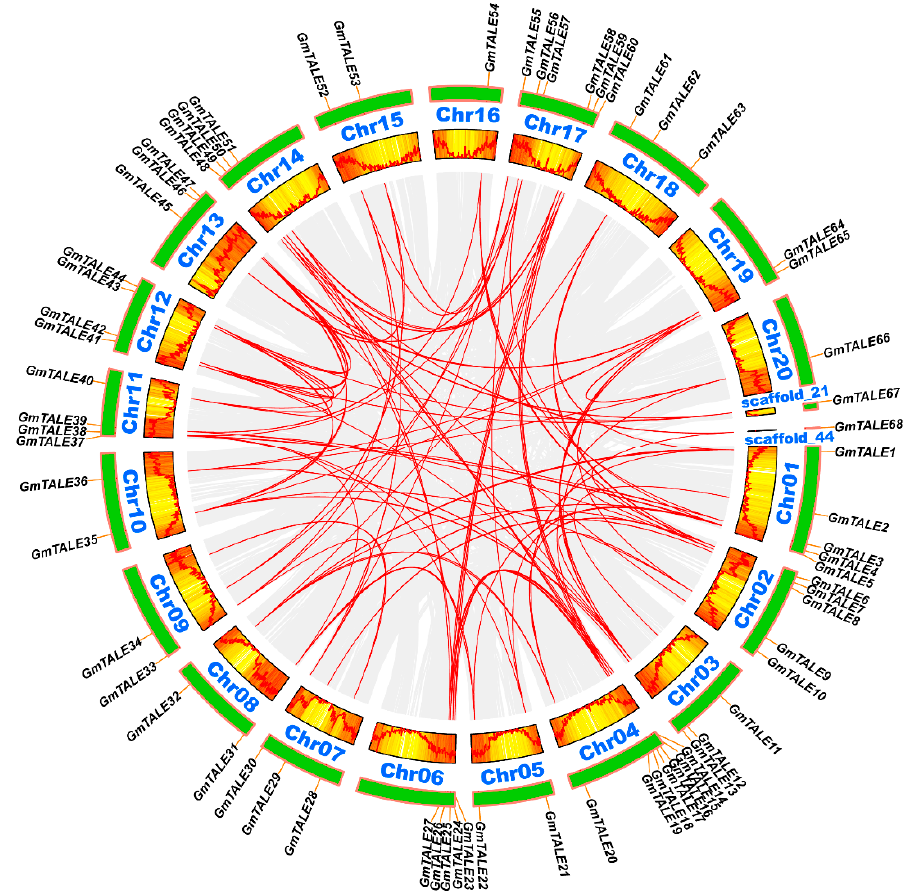
Figure 4. Circos plot displaying the collinearity of GmTALE homologous genes. Genome-wide collinear blocks were set as the background in gray and the duplicated GmTALE gene pairs were linked with red curves. Besides, each soybean chromosome was attached with 300-kb gene density information and depicted by heatmap and wave graph.